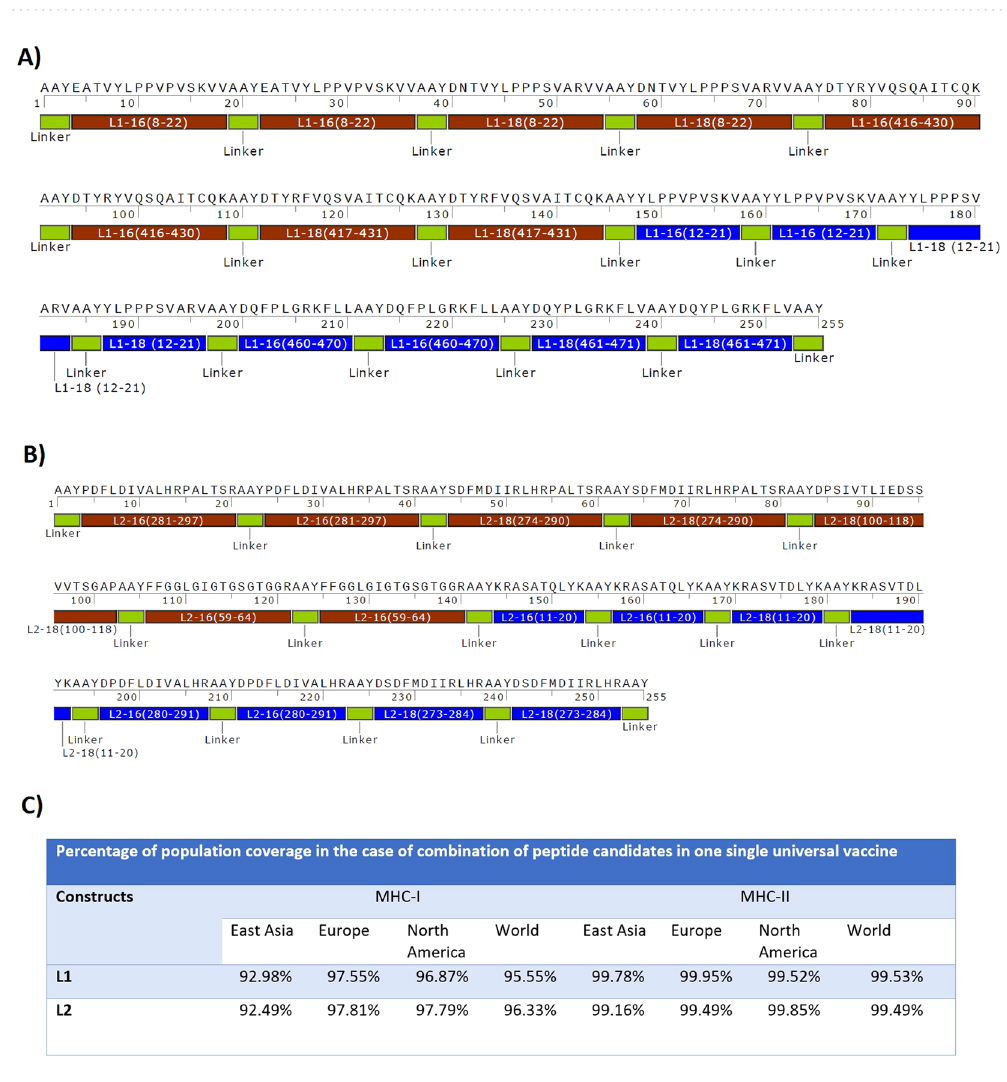
Figure 2. ( A ) L1 construct, ( B ) L2 construct, ( C ) Percentage of population coverage in the combination of peptide candidates in one single universal